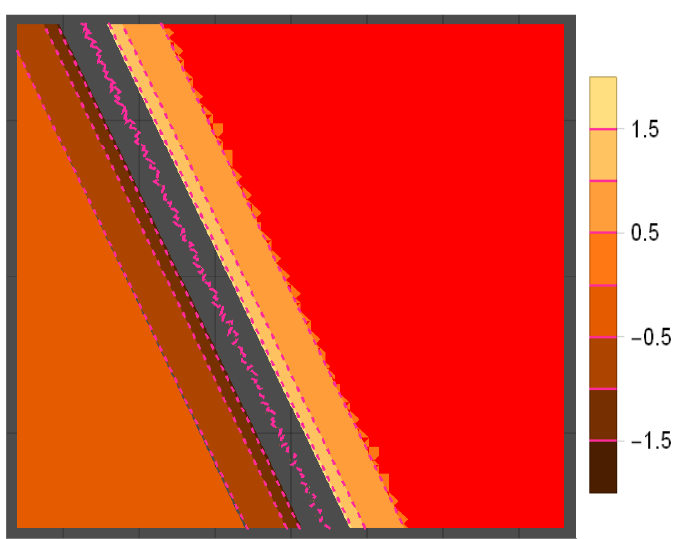
Figure 5. The solitary wave view of the 3D, 2D, and contour plots of U 5 ( x , t ).